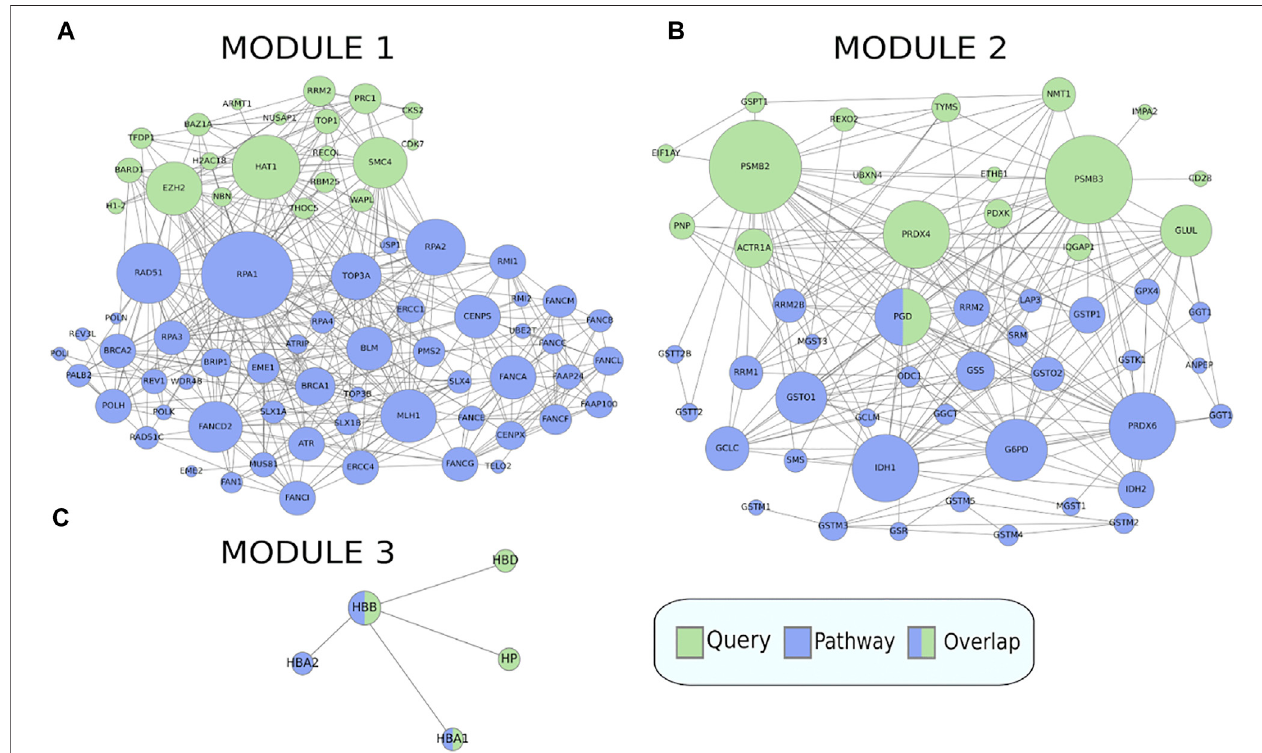
FIGURE 7 | Crosstalk between the three modules in the MSigDB gene set HAHTOLA_SEZARY_SYNDROM_UP and selected KEGG pathways (only genes linked in thenetworkareshown). (A) The “ Fanconi anemia ” pathway which issigni fi cantlyenriched forcrosstalktomodule 1. (B) The “ Glutathionemetabolism ” pathway which is signi fi cantly enriched for crosstalk to module 2. (C) The “ Malaria ” pathway which is signi fi cantly enriched for crosstalk to module 3. The query gene set module genes are marked in green and the pathway genes are marked in